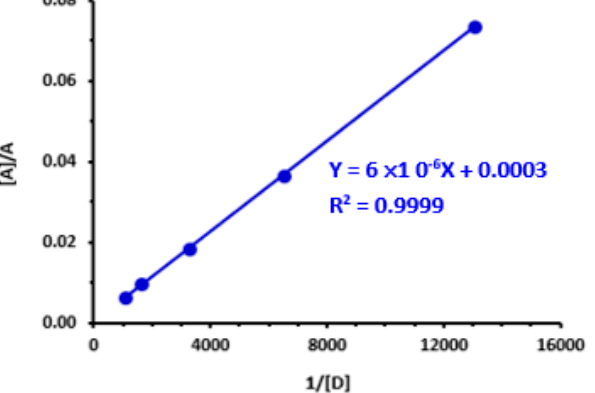
Figure 3. Benesi-Hildebrand plot for the formation of CTC of LOR with DDQ. Linear fitting equation and correlation coefficient (r 2 ) are given on the plot. [A], A and [D] are molar concentrations of DDQ, absorbances of CTC, and molar concentration of LOR, respectively. Table 2. Electronic constants/properties of CTC of LOR with DDQ.